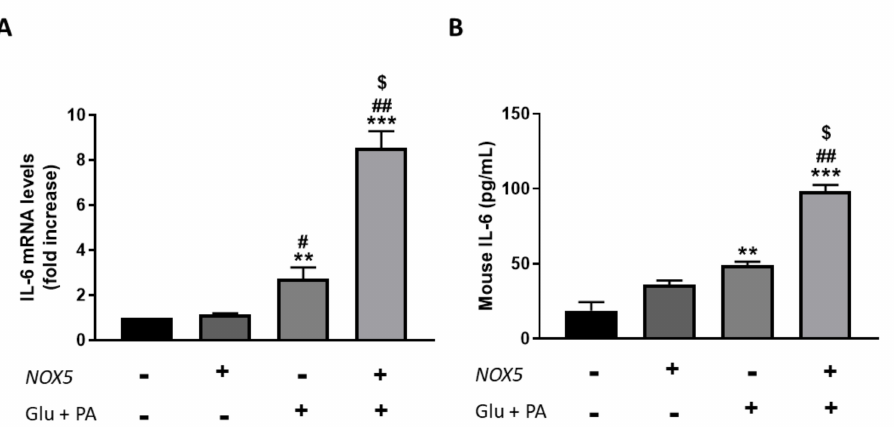
Figure 5. bEnd.3 cells showed higher IL-6 production when incubated for 24 h with glucose (Glu) + palmitic acid (PA) after NOX5 transfection. ( A ) IL-6 mRNA levels of endothelial bEnd.3 cells ( n = 6).( B ) Quantification of IL-6 concentration in culture media of endothelial bEnd.3 cells by an ELISA kit. mRNA levels are relative to Gapdh . Fold increase is relative to control group (Nox5( − )/Glu +PA( − )). Re- sults are expressed as mean ± SEM; ** p < 0.01, *** p < 0.001: differences relative to Nox5( − )/Glu + PA( − ); # p < 0.05, ## p < 0.01: differences relative to Nox5(+)/Glu + PA( − ); $ p < 0.05: differences relative to Nox5( − )/Glu + PA(+). Statistical test used: